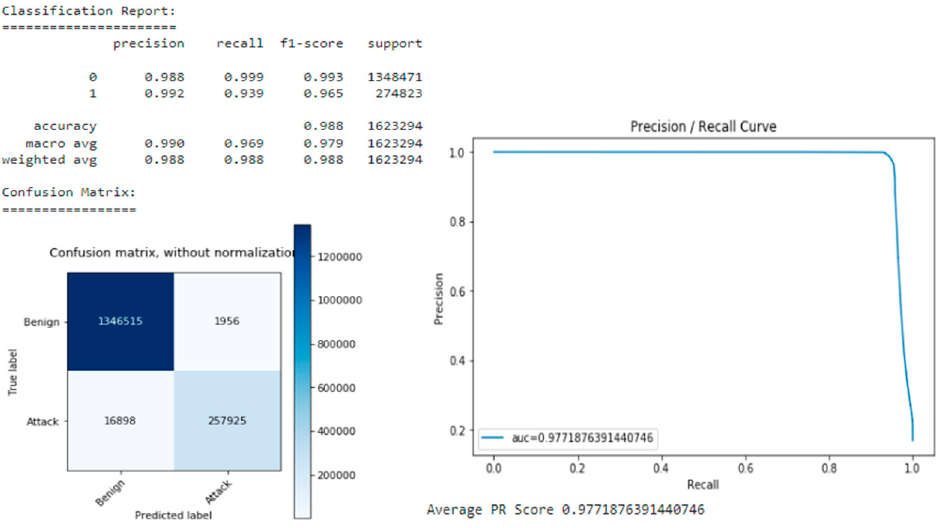
Figure 12. Static Model without class weights.